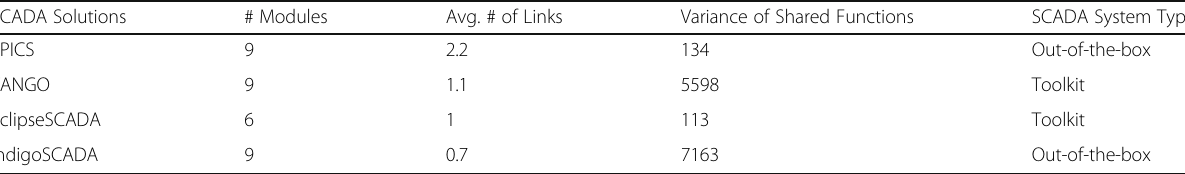
Table 2 Manageability of open-source SCADA solutions SCADA Solutions